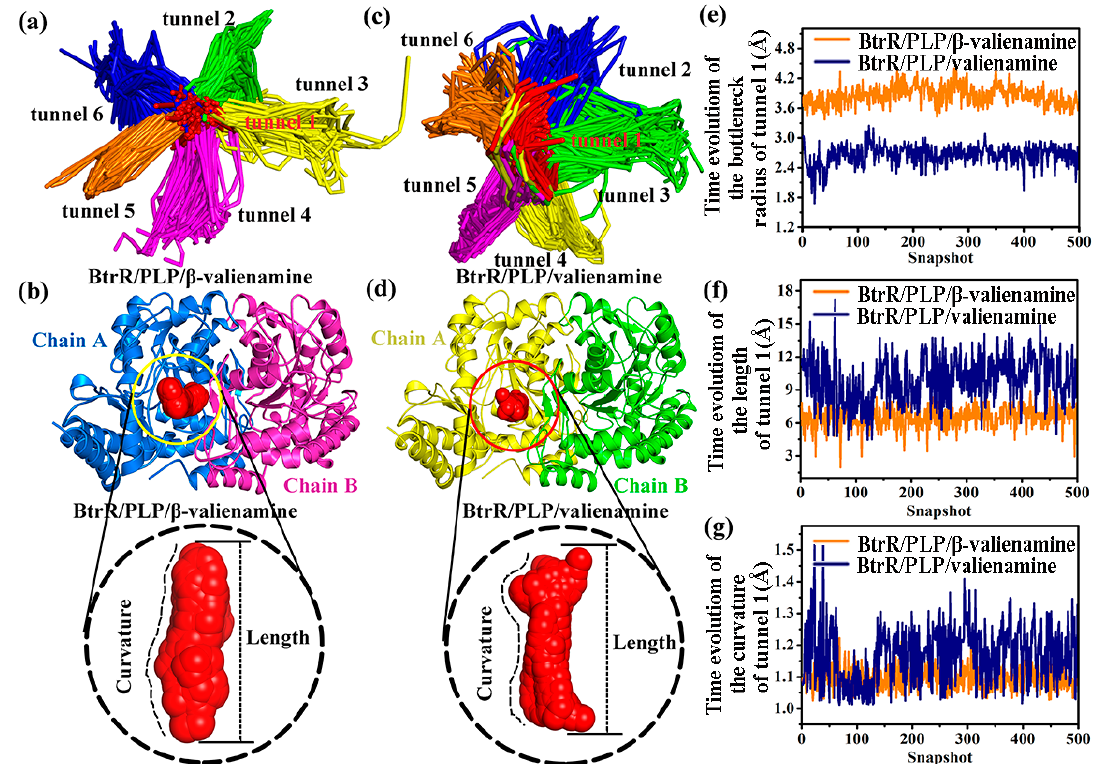
Figure 7. Comparison of the tunnels about the BtrR/PLP/ β -valienamine and BtrR/PLP/valienamine complexes. ( a , c ) The top-ranked collective BtrR tunnels identified using CAVER 3.0 according to the 300-ns MD simulations trajectories. ( b , d ) Shape and size of tunnel 1s for BtrR/PLP/ β -valienamine and BtrR/PLP/valienamine, respectively. ( e – g ) Time evolution of bottleneck radius, curvature, and length of tunnel 1 for BtrR/PLP/ β -valienamine and BtrR/PLP/valienamine complexes, respectively.